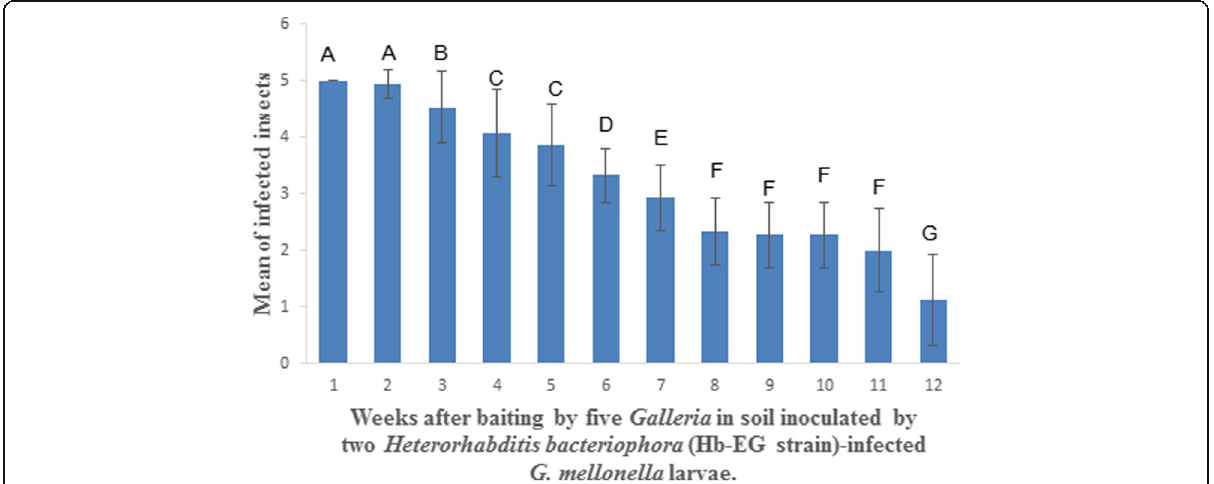
Fig. 1 Heterorhabditis bacteriophora (Hb-EG strain) persistence measured by ability to infect G . mellonella larvae in soil at extended baiting times. Means (± SD) of five insects per cup for 15 replicates (cups). Different letters above bars indicate statistical significance ( P ≤ 0.05) using